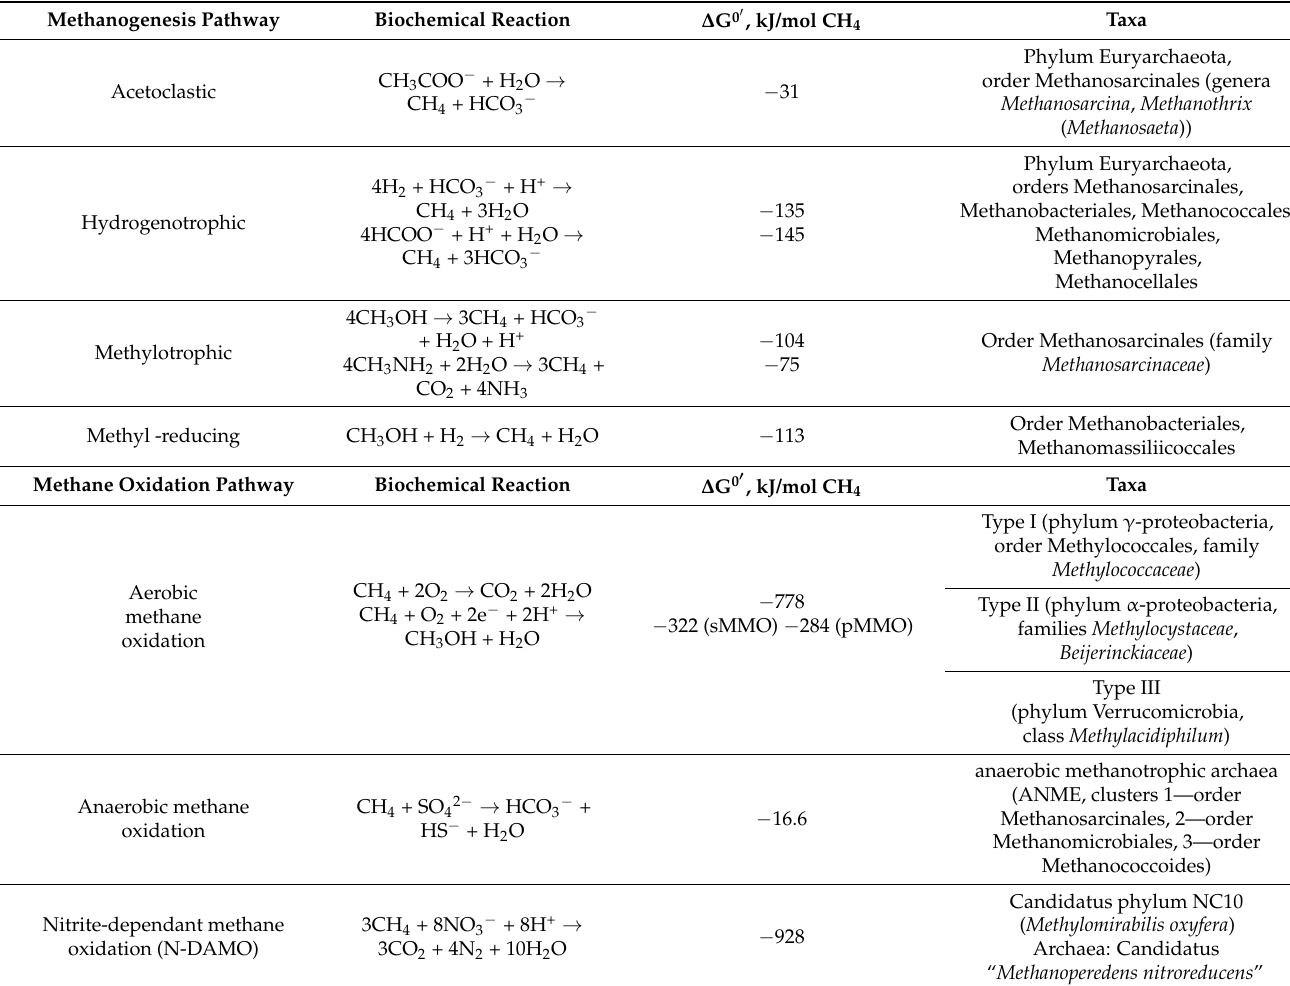
Table 1. Main biochemical reactions of methanogenesis and methanotrophy [20,33,52–54]. Methanogenesis